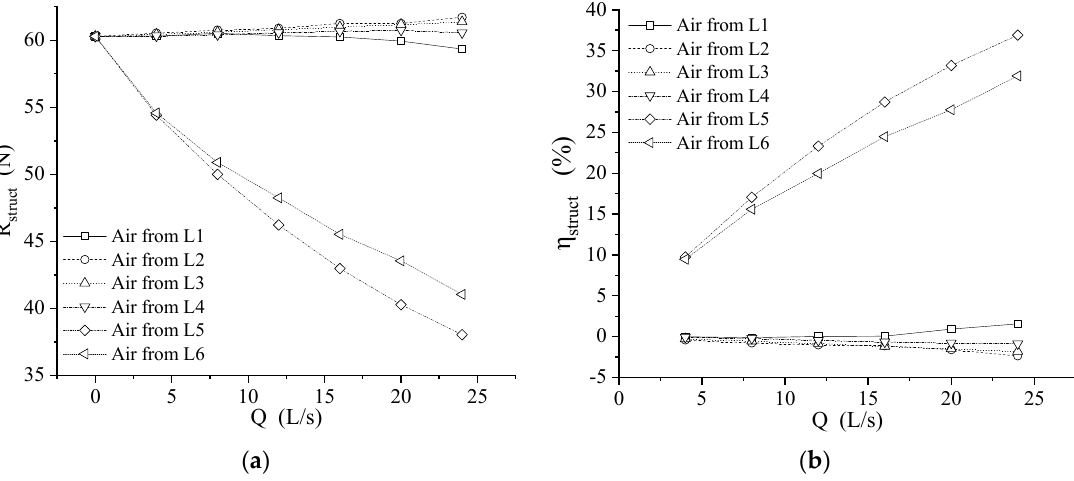
Figure 15. Resistance and drag reduction in the strut with different air injection locations: ( a ) Total resistance; ( b ) Drag reduction.